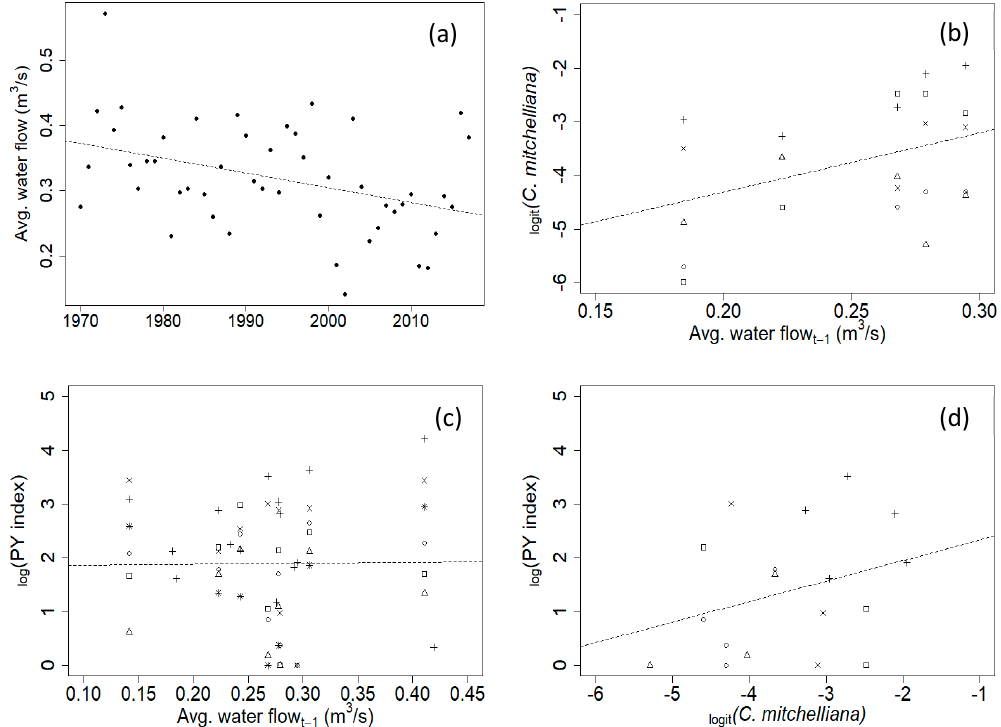
Figure 2. Effects of water availability on plants and butterflies. ( a ) Change in average annual water flow from 1970–2017. ( b ) Average amount of C. mitchelliana present based on average annual water flow of previous water year. ( c ) Pollard-Yates (PY) index of St. Francis’ satyrs based on average annual water flow of previous water year. ( d ) Relationship between amount of C. mitchelliana and PY index of St. Francis’ satyrs. Different symbols represent an individual site where butterfly or plant surveys were conducted.